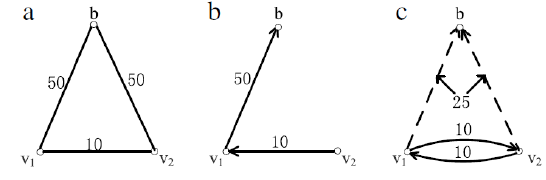
Fig. 2. Illustration of cooperative data aggregation